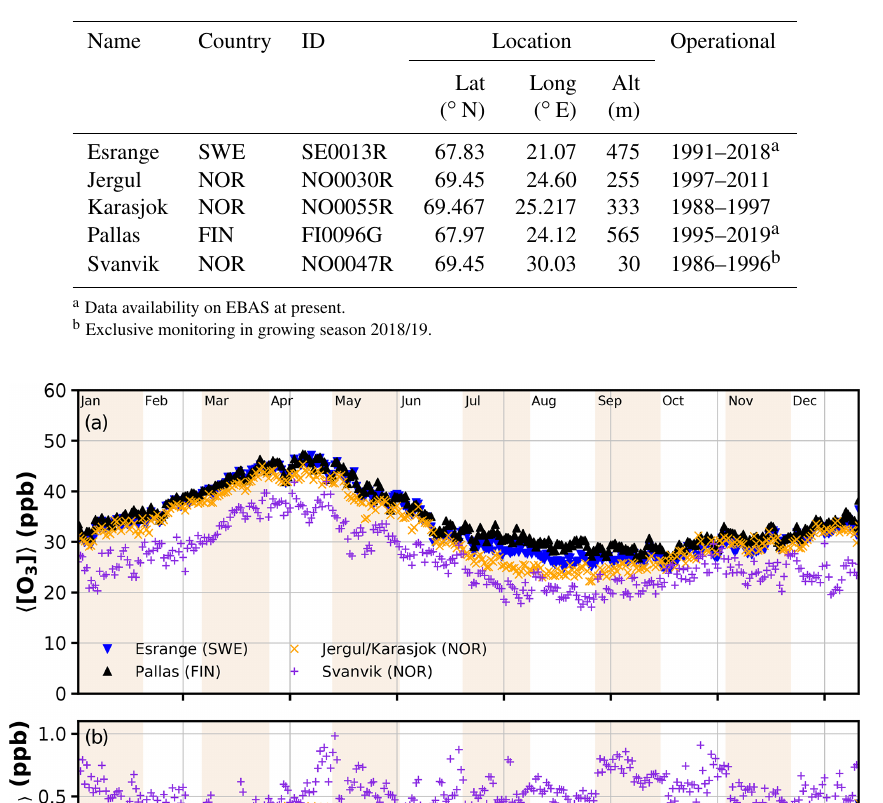
Table 1. Past and present ozone observation sites in northern Fennoscandia. Data are available from http://ebas.nilu.no/ (last access: April 2021).